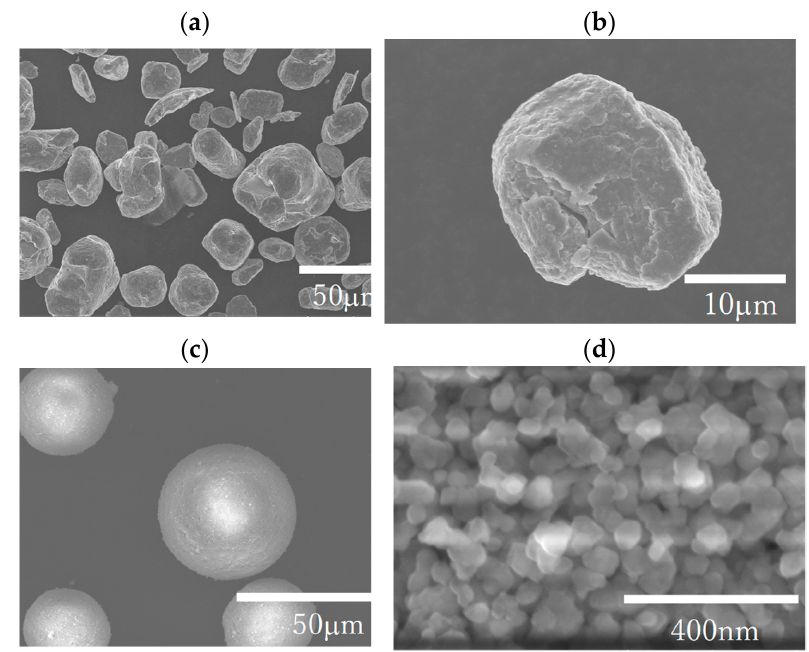
Figure 7. SEM images of SUS304 powders sieved through a 400 mesh ( a , b ) and ZrO 2 powders ( c , d ). ( a , c ) are low magnification images and ( b , d ) are high magnification images.